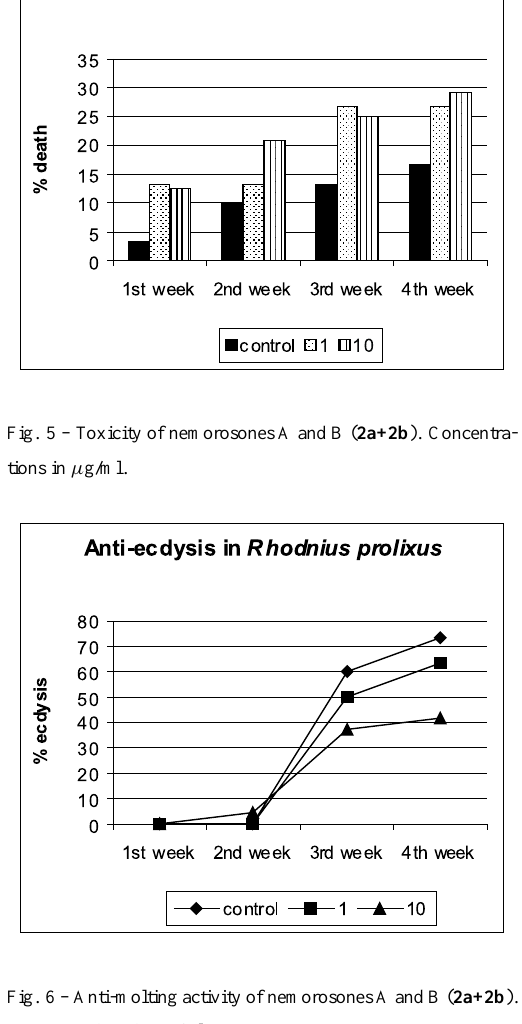
Fig. 6 –Anti-molting activity of nemorosonesA and B ( 2a+2b ). Concentrations in µ